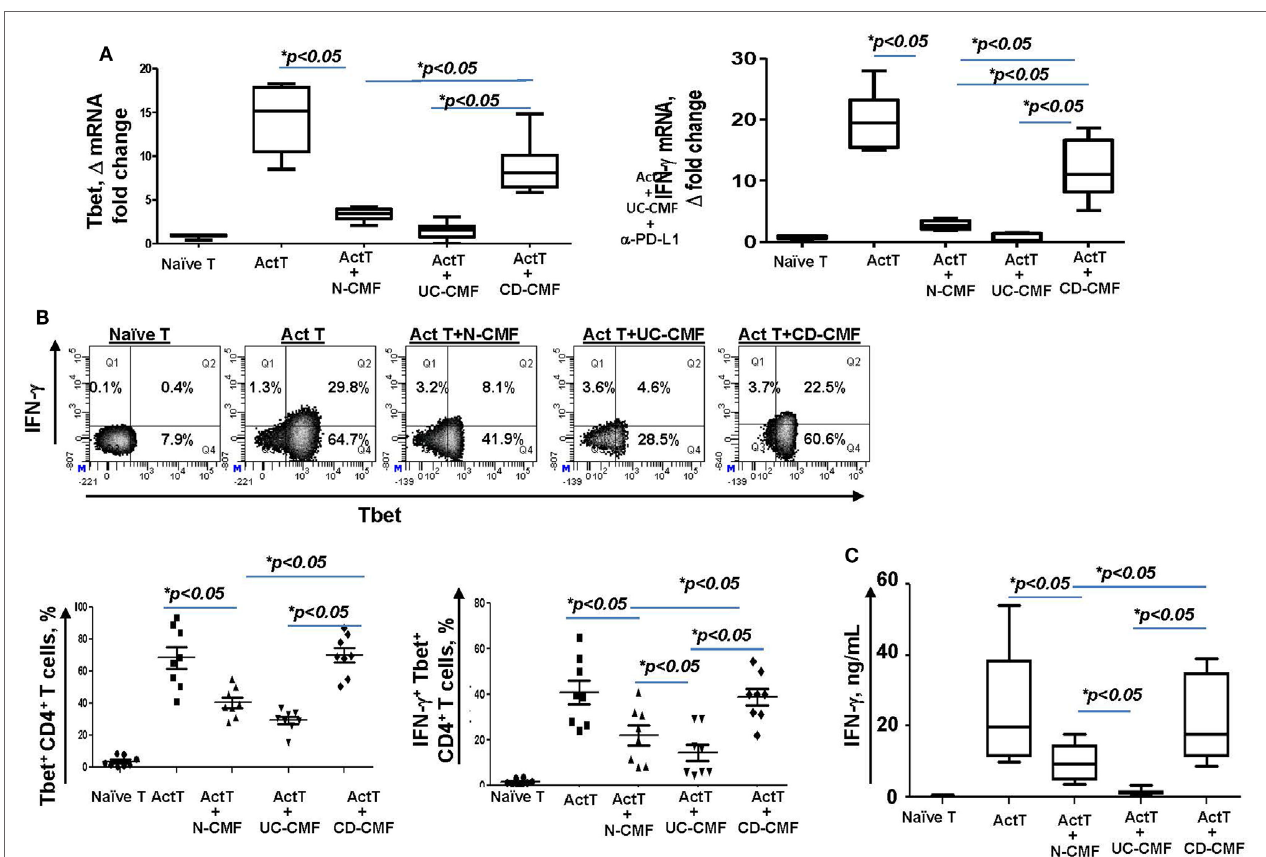
FigUre 6 | UC-CMFs demonstrate strong suppression of Th1 type responses in the CD3/CD28-activated CD4 + T cells, while CD-CMF-mediated suppression was significantly reduced. (a) Tbet and IFN- γ mRNA expression by the T cells was analyzed using real-time RT-PCR analysis. The means ± SEM are shown, n = 4 allogeneic donor pairs per group, two experimental replicates each. (B) The percentage of the T cells expressing Th1 transcription factor Tbet and the Th1 cytokine IFN- γ was analyzed using intracellular immunostaining for flow cytometry. The means ± SED are shown, n = 8 allogeneic donor pairs per group. (c) IFN- γ production was analyzed using singleplex cytokine analysis. The means ± SD are shown, n = 8 allogeneic donor pairs per group, two experimental replicates